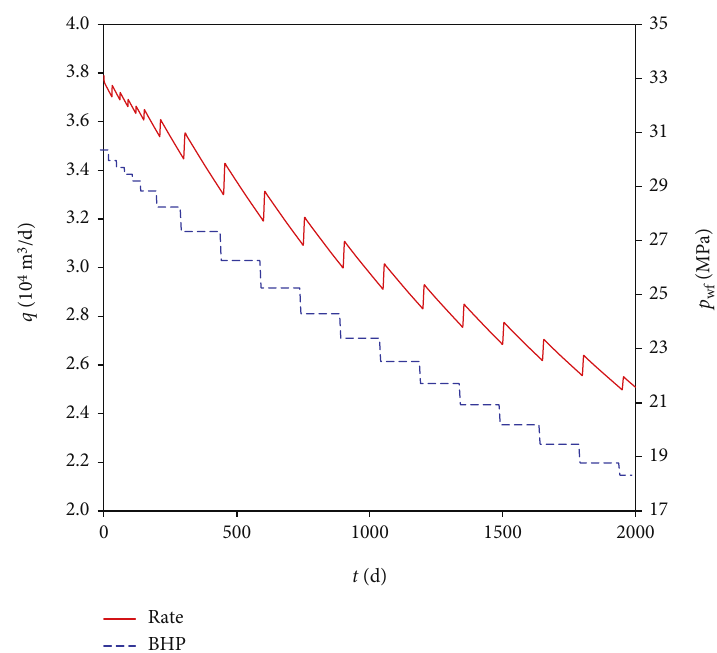
Figure 14: Production history of the gas well under variable BHP and variable rate conditions.